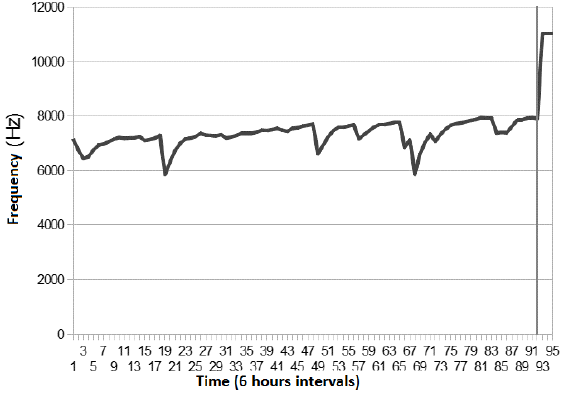
Figure 15. Tests results in a real production environment.